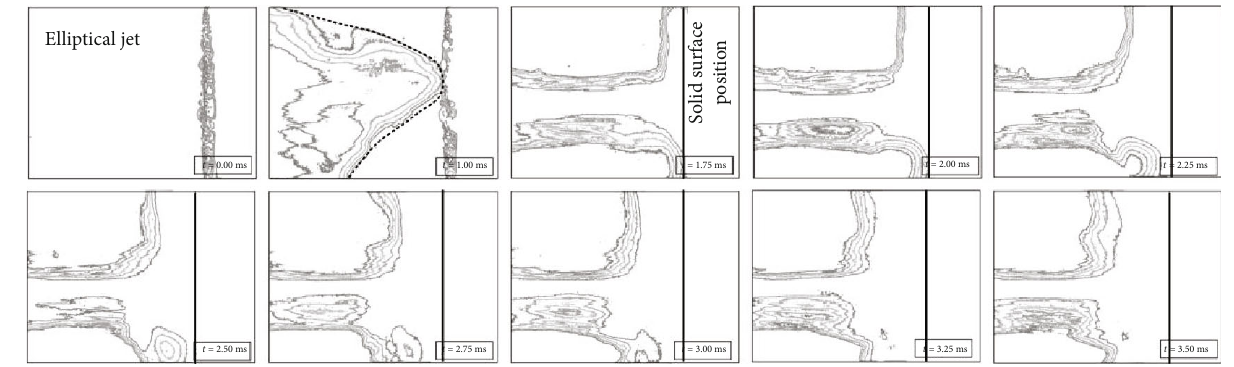
Figure 10: The evolutions of an elliptical jet impacting a solid